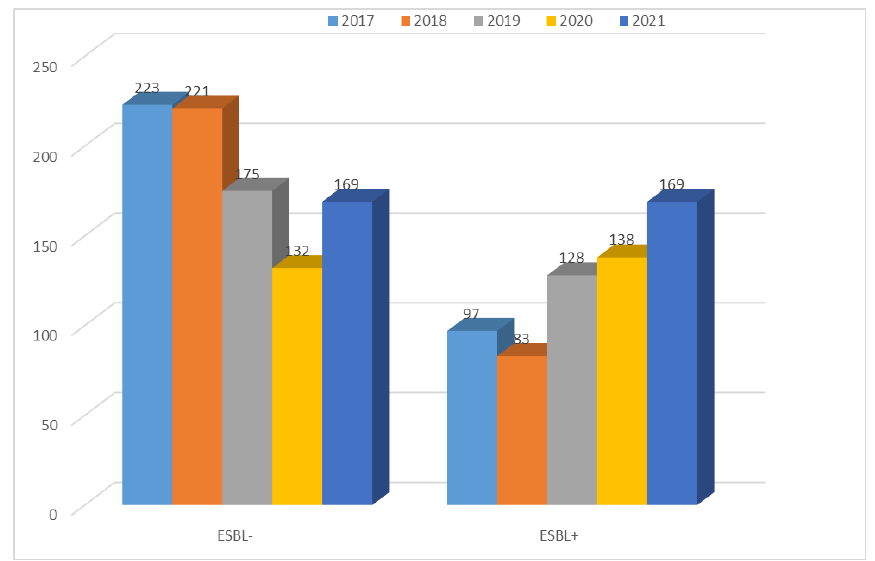
Figure 11. Comparison of the number of K. pneumoniae ESBL(+) and ESBL(−) strains from 2017 to 2021.